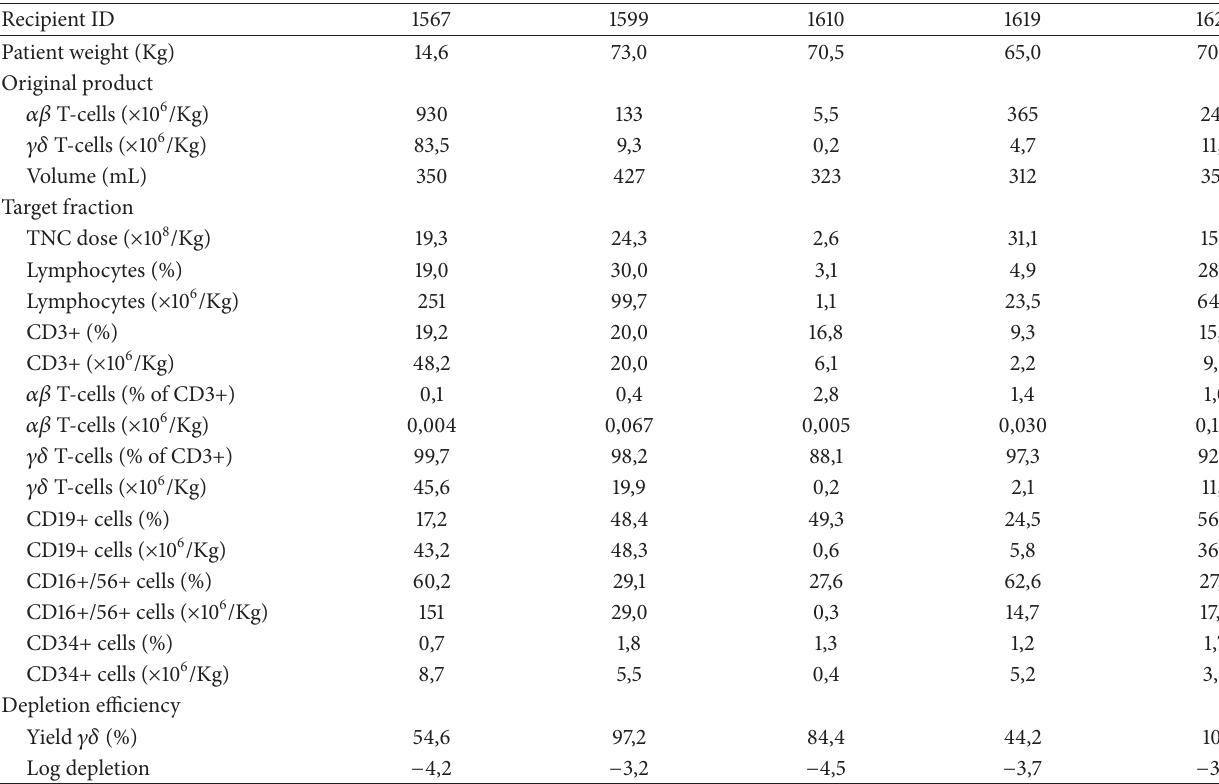
Table 2: Graft characteristics.